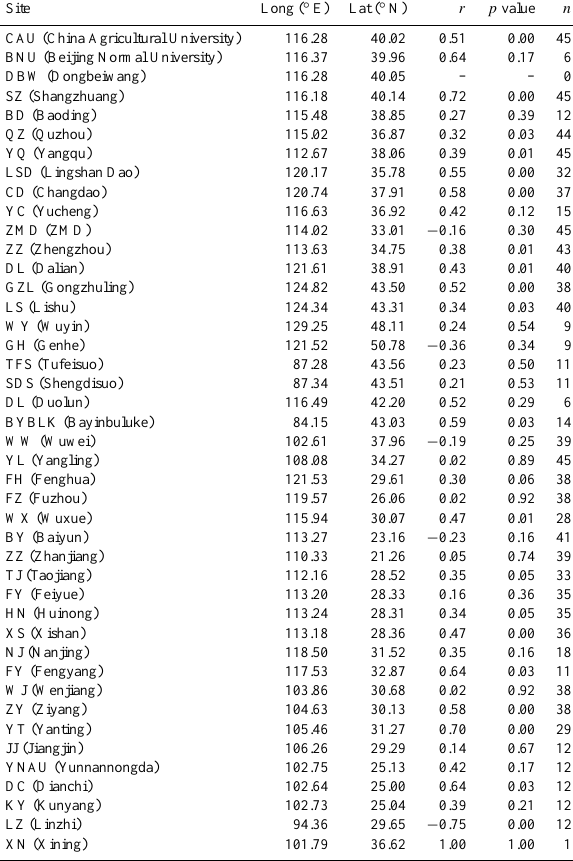
Table A2. Statistical analysis of the NNDMN data set and monthly IASI satellite surface concentrations comparison for each stations during 2009, 2010, 2011, 2012 and 2013. Each site is characterized by its name and coordinates, its Pearson’s correlation coefficient ( r ) and the associated p value as well as its number of points ( n ). Only monthly values with a relative IASI retrieval errors below 100% have been taken into account.